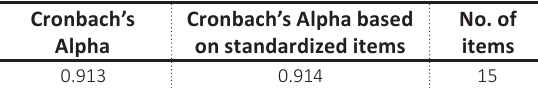
Table 6. Reliability indicators